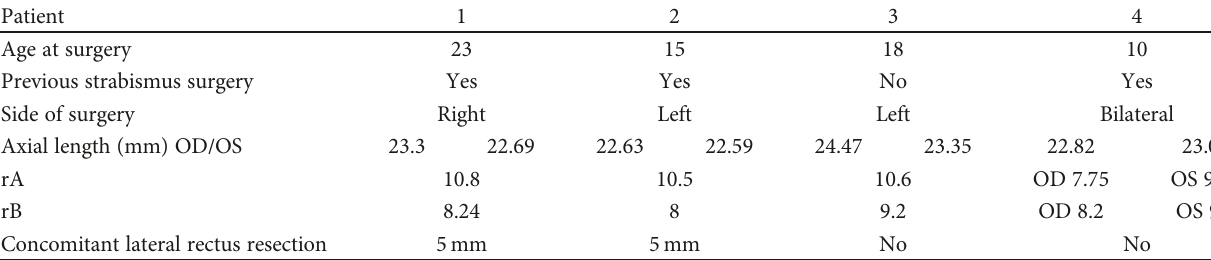
Table 1: Patient characteristics and surgical data.